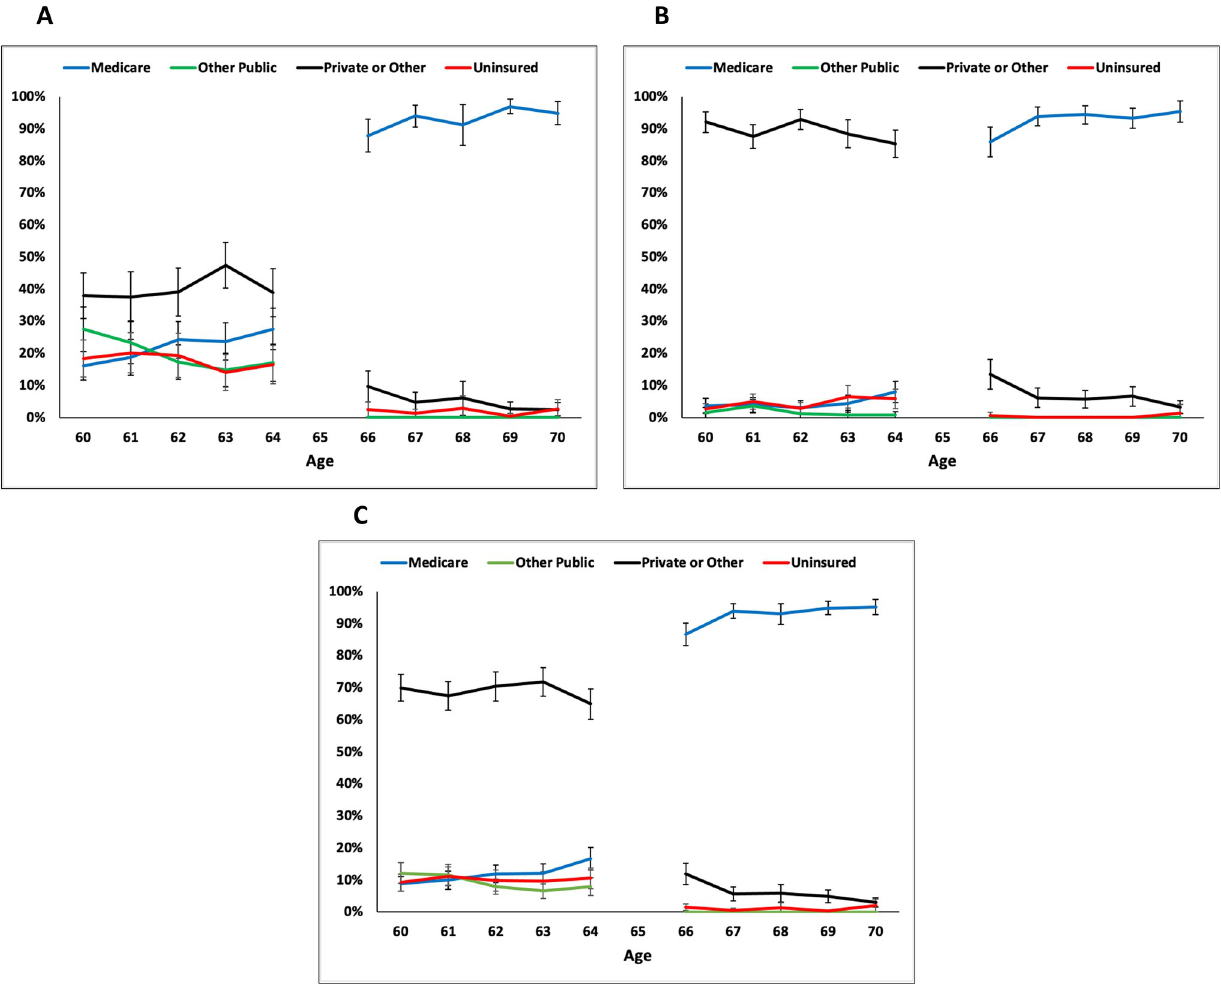
Fig 1. Percentage of US adults with health insurance coverage by income-level, age 60 to 70 years. The percentage of US adults covered by each type of health insurance. A large change in the percentage of US adults insured by Medicare is observed from age 64 to 66 years in the low-income (Panel A), higher-income (Panel B), and overall (Panel C) populations. (A) Low-income adults. (B) Higher-income adults. (C) Overall population.